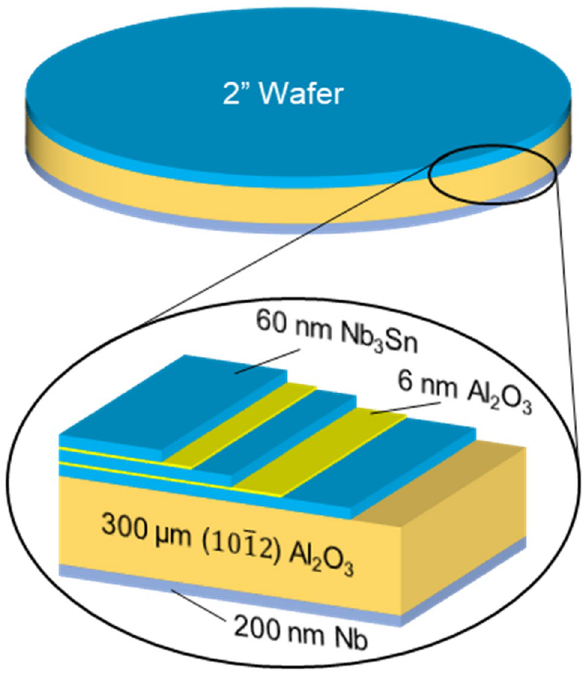
Figure 1. Schematic of Nb 3 Sn/Al 2 O 3 multilayer heterostructures on Al 2 O 3 wafer. Back side of Al 2 O 3 wafer is coated with a thick Nb